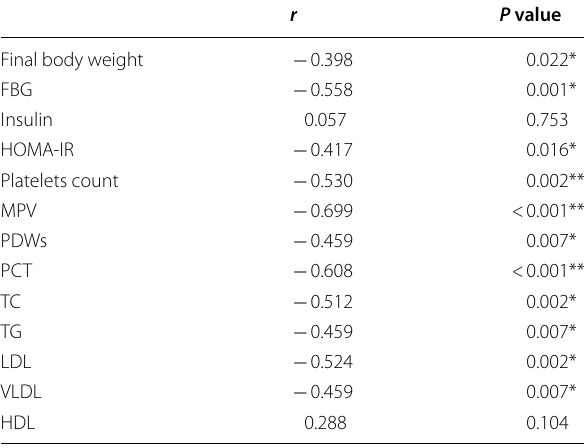
*Significant level at p < 0.05